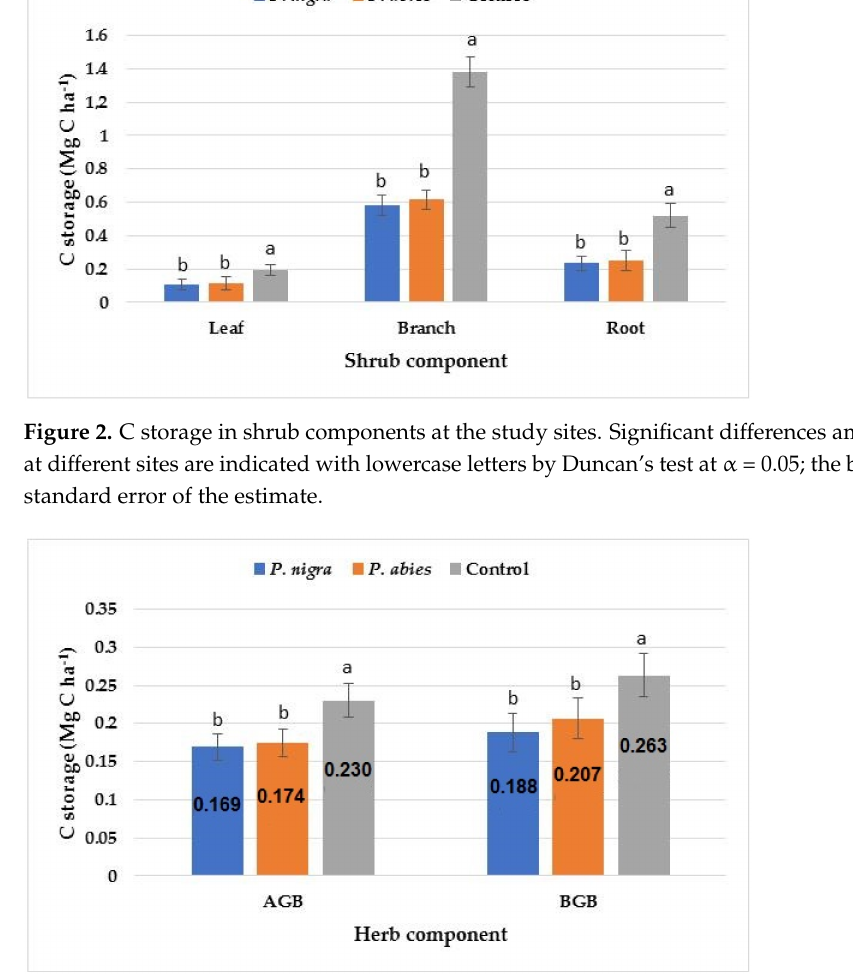
Figure 3. C storage in herb components at the study sites. Significant differences among the means at different sites are indicated with lowercase letters by Duncan’s test at α = 0.05; the bars indicate the standard error of the